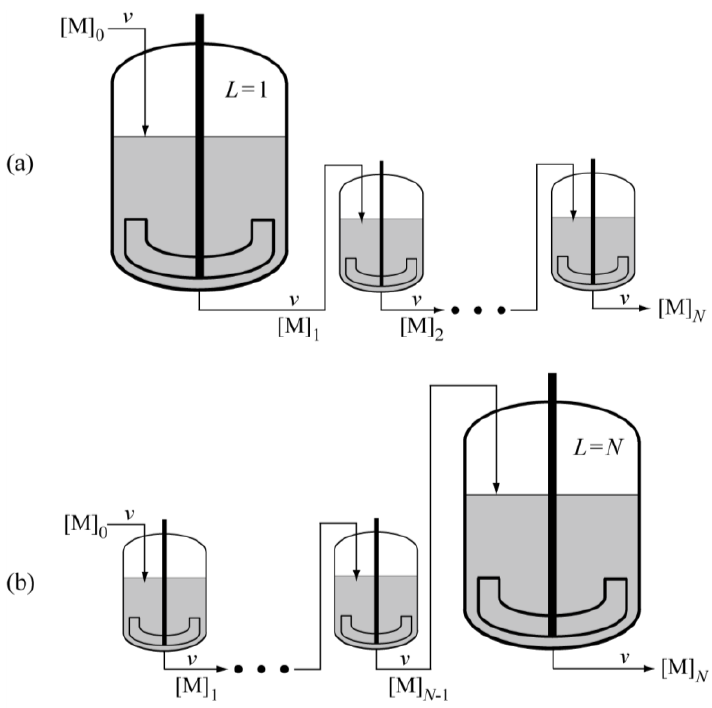
Figure 7. Illustrative representation of the N CSTRs in series, with the arrangement of ( a ) the first large tank L = 1; and ( b ) the last large tank L = N